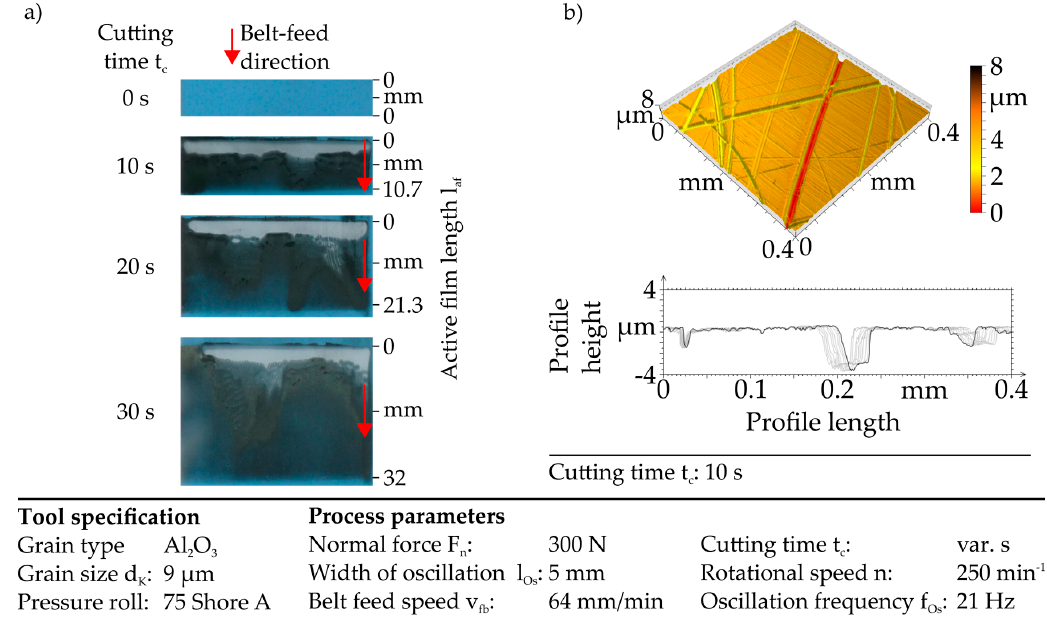
Figure 8. Subsequent microfinishing using a film with a grain size of d K = 9 µm. ( a ) Tool wear; ( b ) surface topography and profile series.